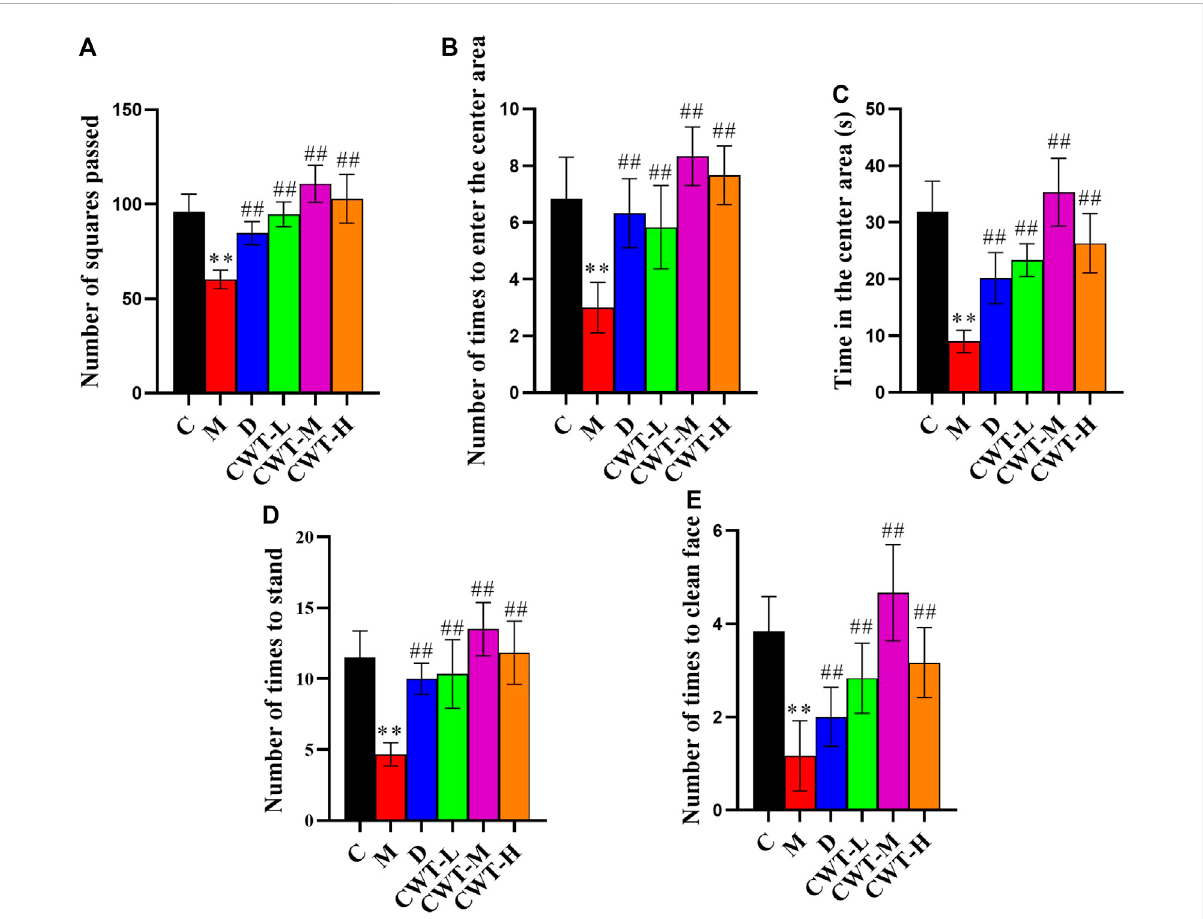
FIGURE 7 Behavioral analysis results for the rats in each group after 7 days of treatment (C, control group, n = 10; M, model group, n = 10; D, diazepam group, n =10;CWT-Lgroup, n =10;CWT-Mgroup, n =10;CWT-Hgroup, n =10;comparedwiththeCgroup,* p < 0.05,** p < 0.01; compared with the M group, # p < 0.05, ## p < 0.01, mean ± SD). (A) Total number of squares passed; (B) Number of times the rats entered the central area; (C) Residence time in the central area; (D) Standing times; (E) Instances of facial